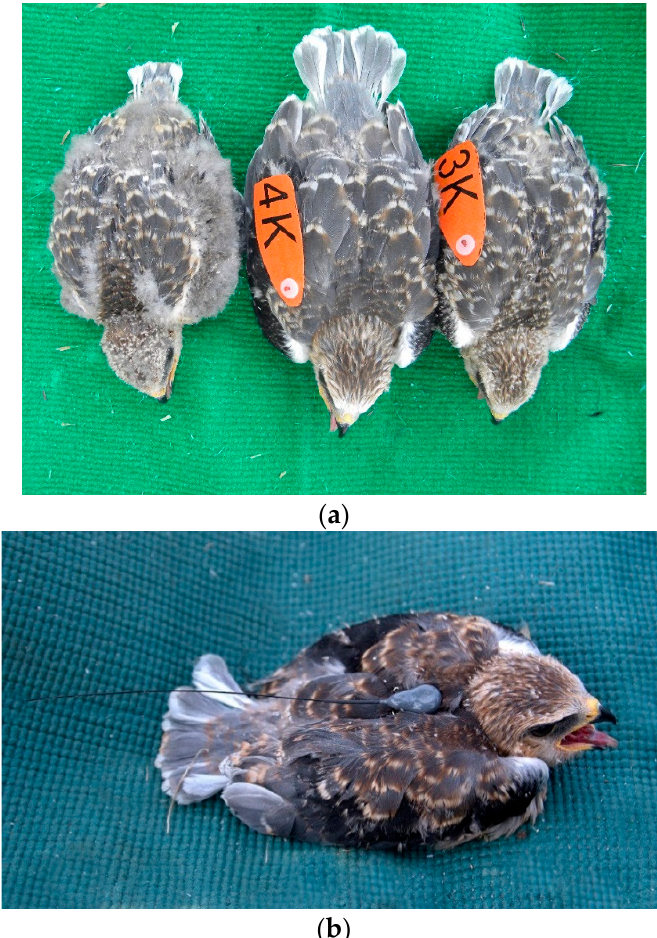
Figure 1. The photographs depicted ( a ) a brood of three nestlings with two of them wearing wing tags on the right wing; ( b ) a nestling equipped with an emisor.